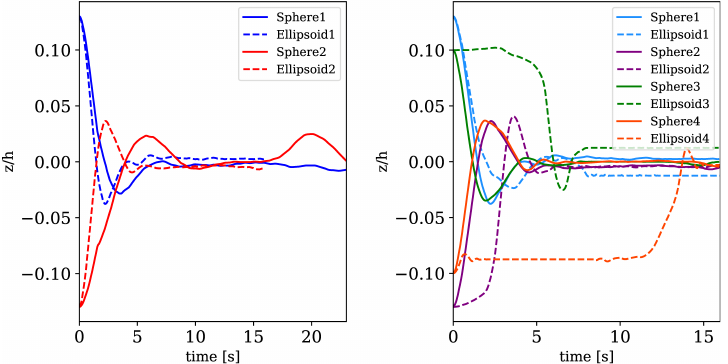
Figure 12. Motion of the center of masses over time for simulations containing two and four solid particles. Solid and dashed lines represent spherical particles and non-spherical particles,